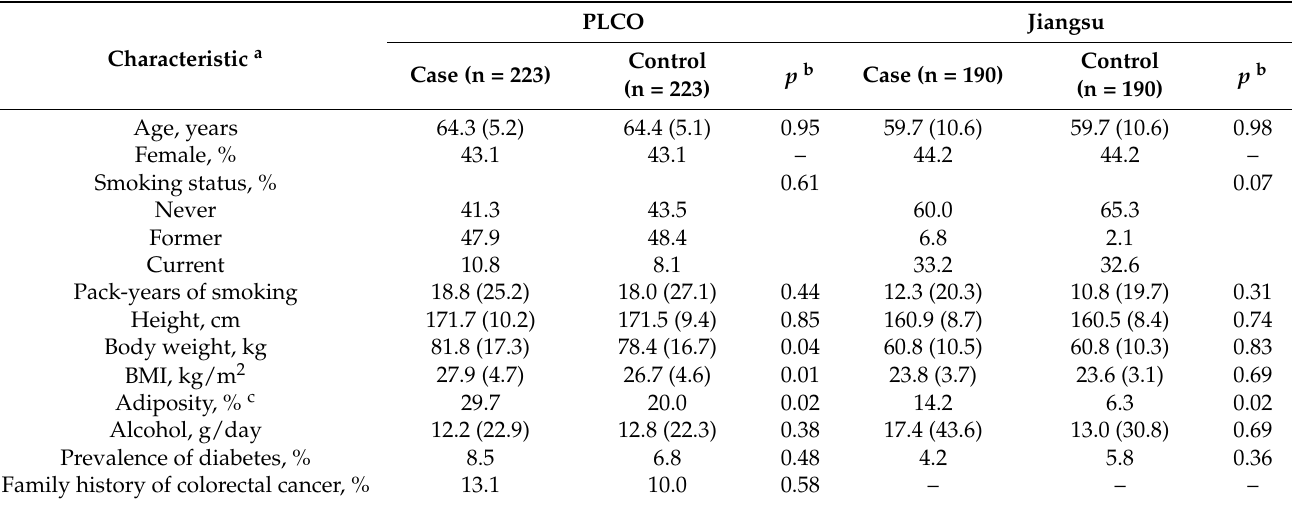
Table 1. Baseline characteristics of colorectal cancer cases and controls from the PLCO and Jiangsu co-